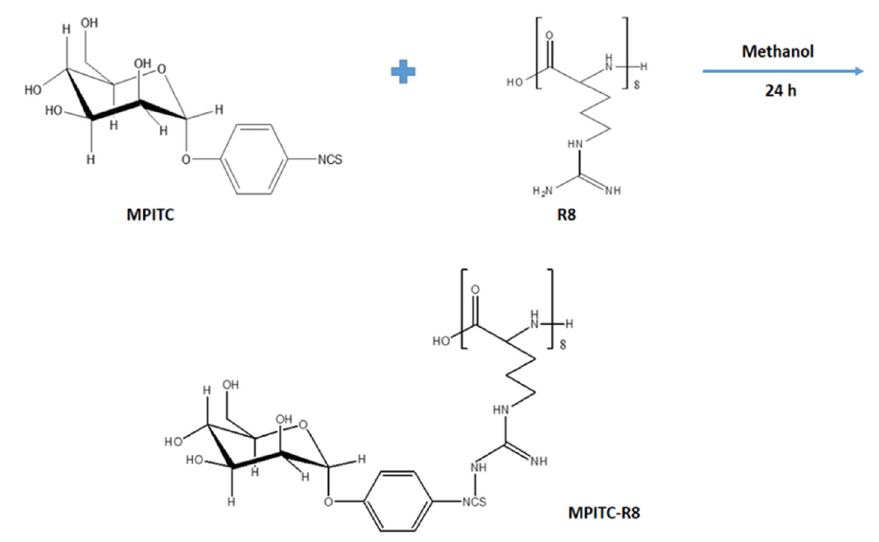
Figure 1. Synthesis scheme of MPITC-R8 conjugate.